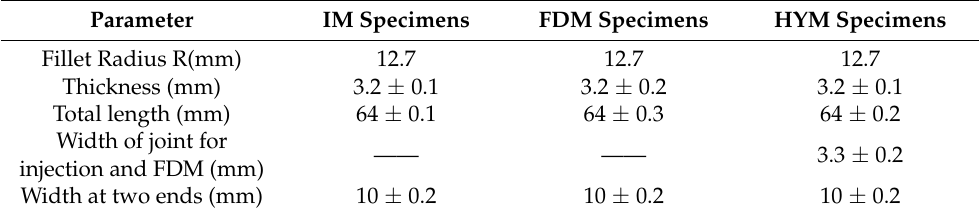
Table 2. Dimensions of all fabricated samples.